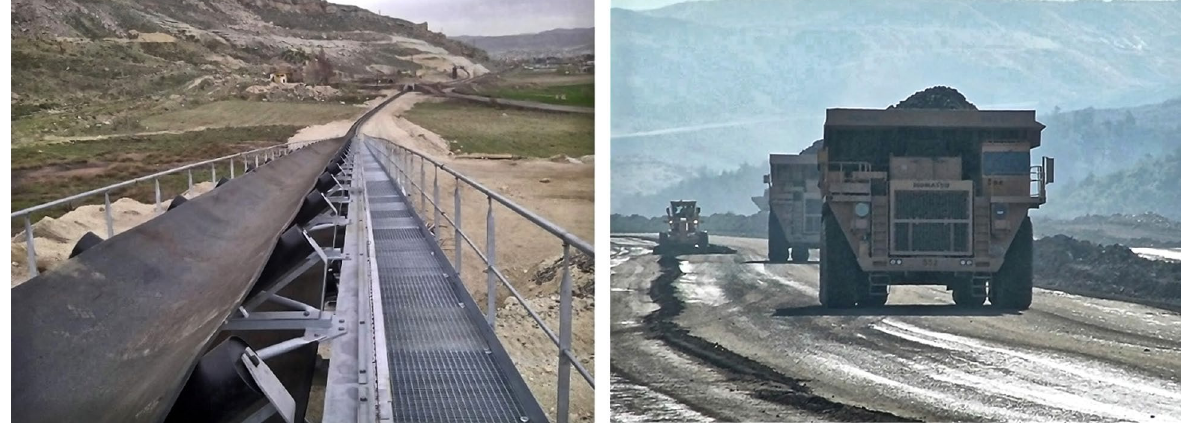
Fig. 2. Belt conveying and truck haulage